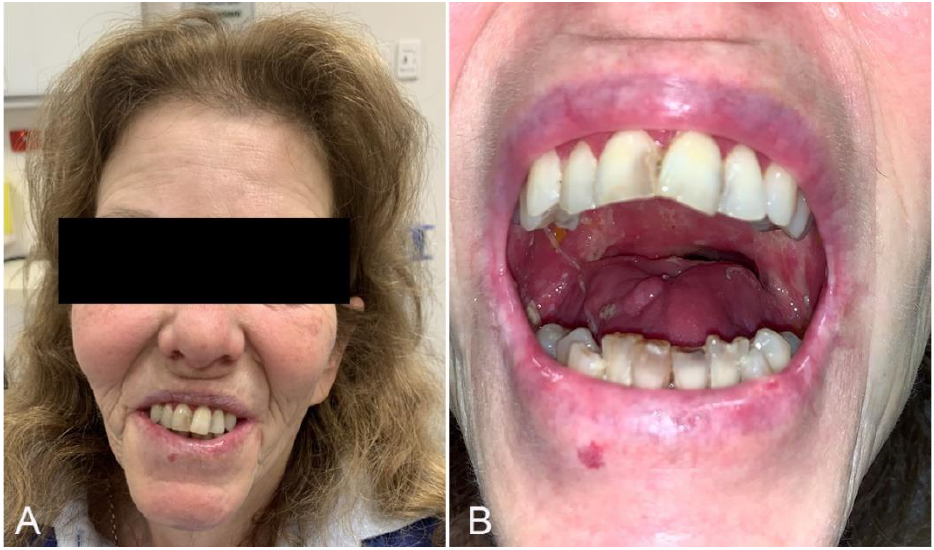
Figure 3. ( A ) 8 month post-operative unsupported mouth closure; ( B ) 8 month post-operative mouth opening.